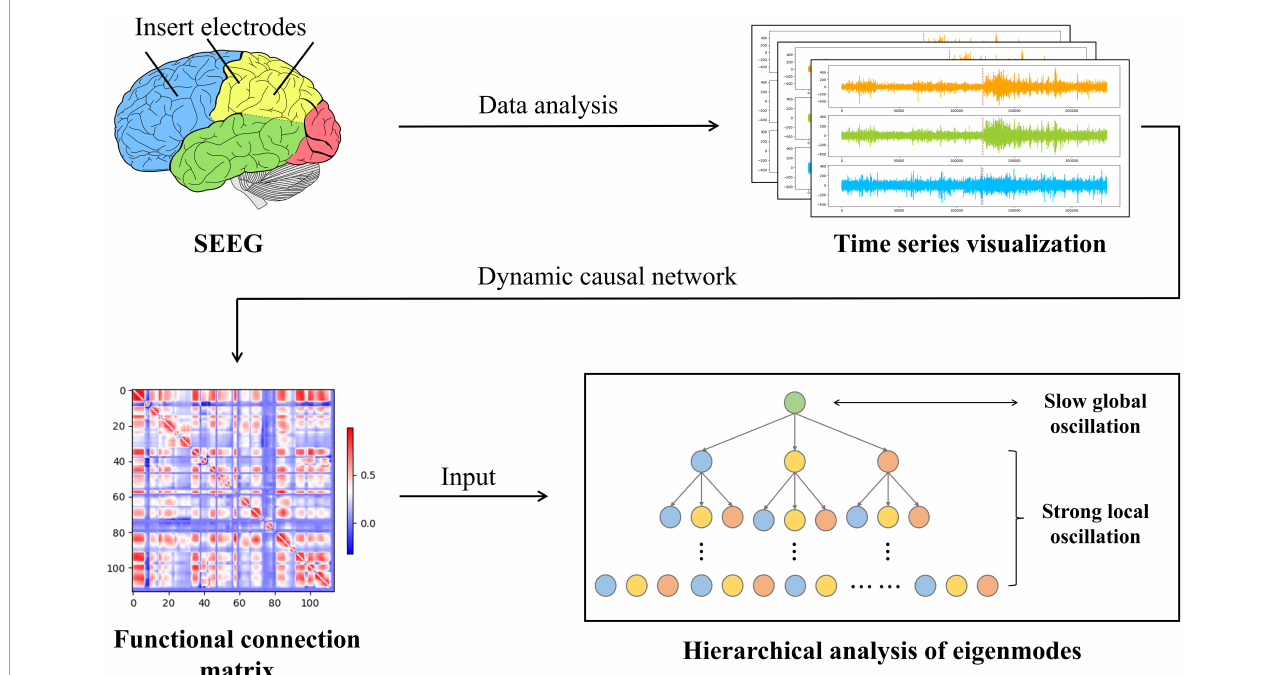
FIGURE2 The entire workflow of the experimental procedure is in this paper. First, the SEEG data are examined, processed, and computed to establish the network of causal effects. The epilepsy causal impact network then generates a functional connectivity matrix that reflects the synchronization and causality between SEEG data from various locations. Immediately after this, we conducted a statistical analysis of the functional connectivity matrix using eigenmode hierarchical analysis to capture the slow global oscillation index vs. the strong local oscillation index for each patient under each data sample.